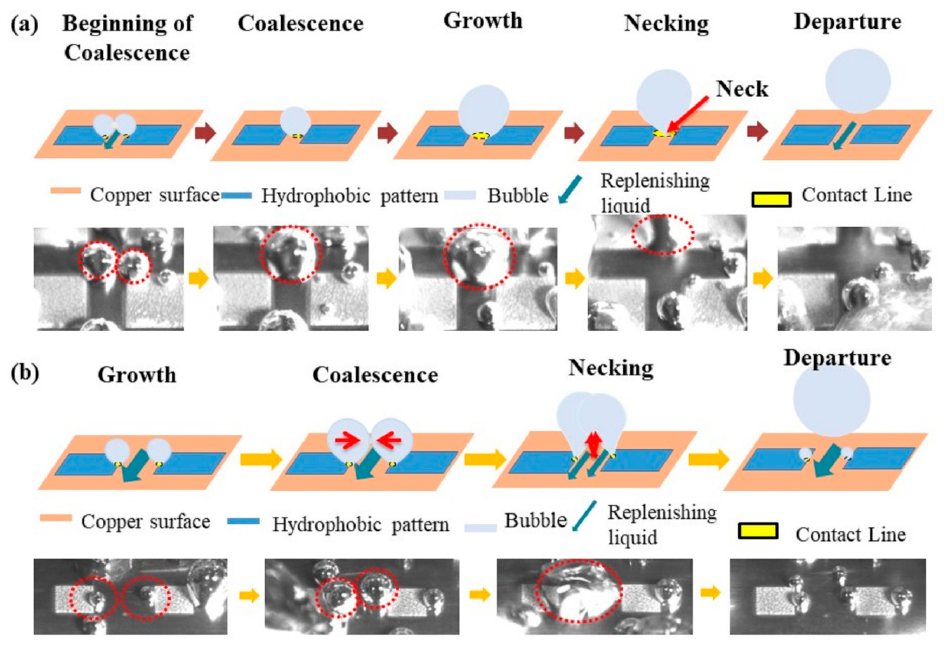
Figure 5. Bubble merging mechanism in axial direction ( a ) earlier inter coalescence of bubbles and ( b ) inter coalescence of bubbles after their isolated development, at a constant heat flux of 7 kW/m 2 .